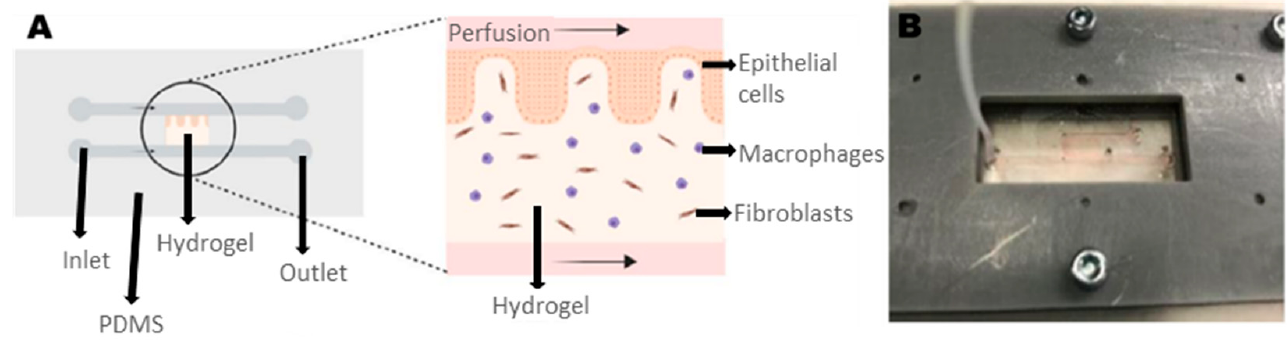
Figure 5. ( A ) Bioprinted gut-on-a-chip model. ( B ) Photograph of the chip and holder, with perfused medium. Reprinted and edited with permission granted under CC-BY license. Published in a Final